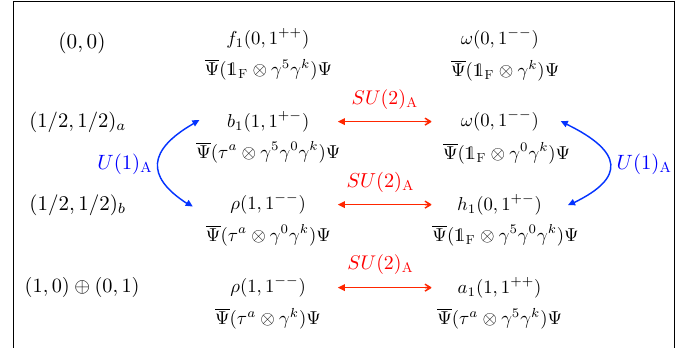
SU ( 2 ) R classification of the J = 1 meson operators. Operators that are connected Figure 1. SU ( 2 ) L × SU ( 2 ) R and U ( 1 ) A transformations are linked by the red and blue arrows, respectively. by the SU ( 2 ) L × The figure is from Ref.